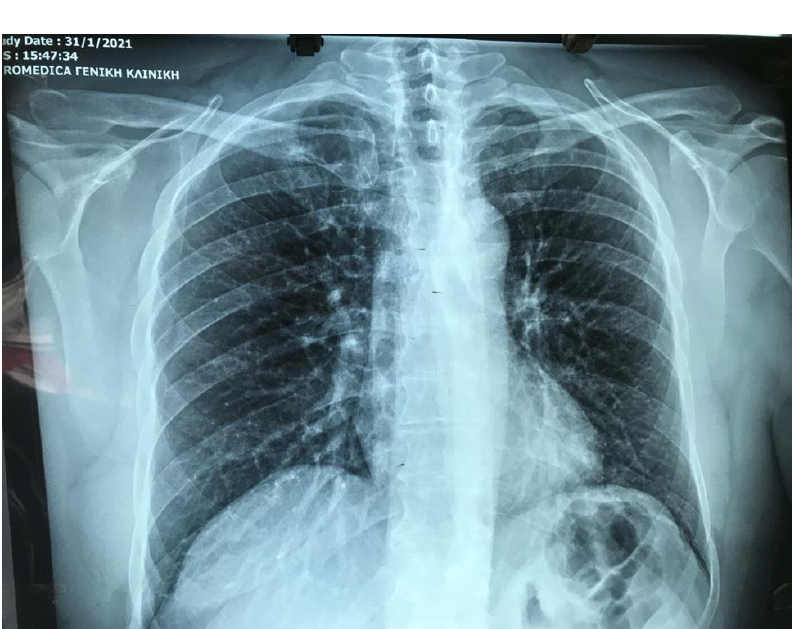
Figure 1. ECG of the patient showing normal pattern.